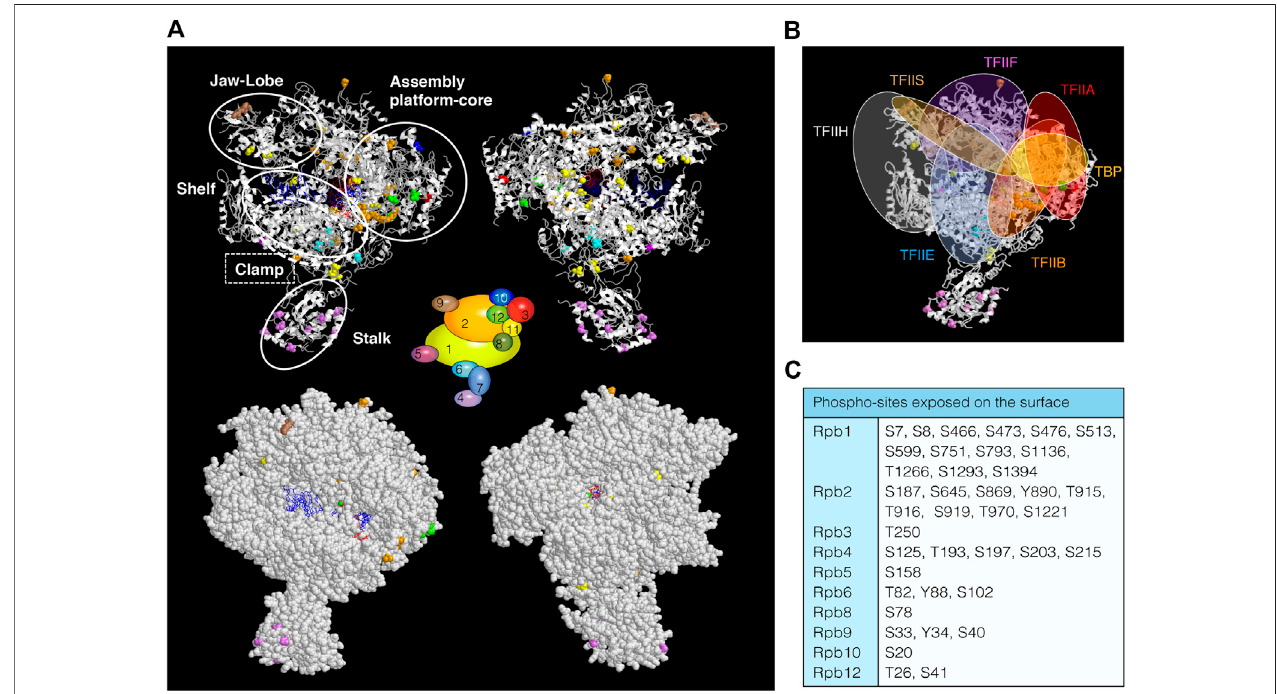
FIGURE 1 | RNAPII phospho-sites. (A) Upper, schematic views (ribbon representation) of Saccharomyces cerevisiae RNAPII (PDB: 1y1w), displaying phospho- sitesthathavebeenlabelledindifferentcoloursaccordingtothe12subunitsdiagramshowninthemiddleofthe fi gures.RNAPIImobilemodulesareindicatedwithwhite open circles. DNA is represented in blue and RNA in red. Surface ( bottom ) views showing exposed phospho-sites. (B) Schematic representation of GTFs localizations according to published works (i.e., (Sainsbury et al., 2015; Schier and Taatjes, 2020)). (C) Table with phospho-sites exposed on the surface of RNAPII whose phosphorylation status could be important for the association/dissociation of transcription